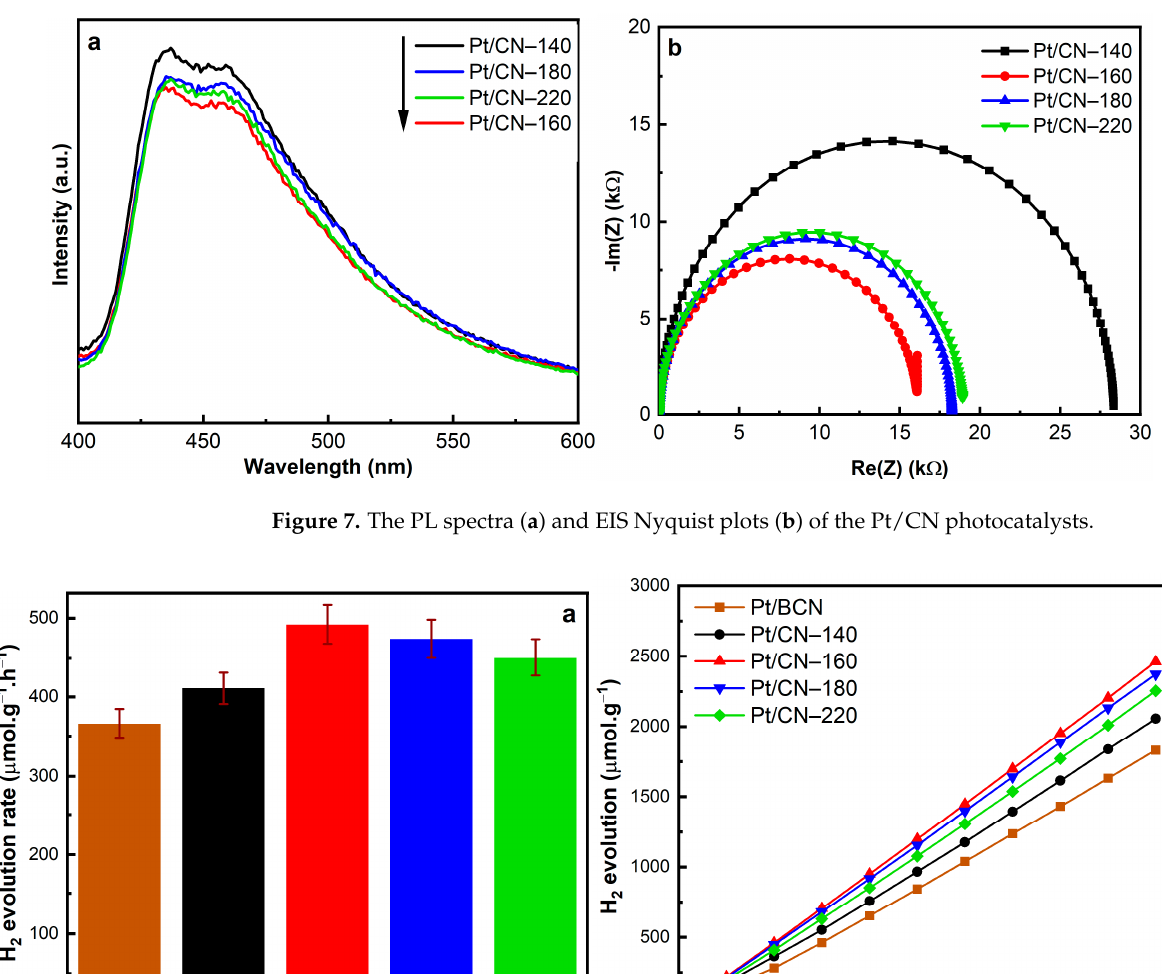
Figure 6. The UV–Vis spectra of the Pt/CN photocatalysts (inset: the corresponding Tauc plots).